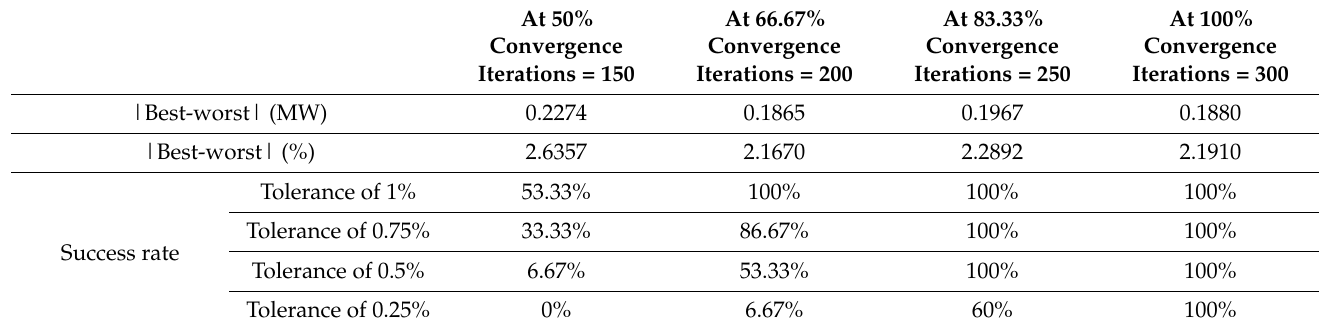
Table 6. Success rate of the proposed TLBA for the minimization of the ETLs of the IEEE 30-bus network. At 100% At 83.33% At 66.67% At 50% Convergence Convergence Convergence Convergence Iterations = Iterations = 250 Iterations = 200 Iterations = 150